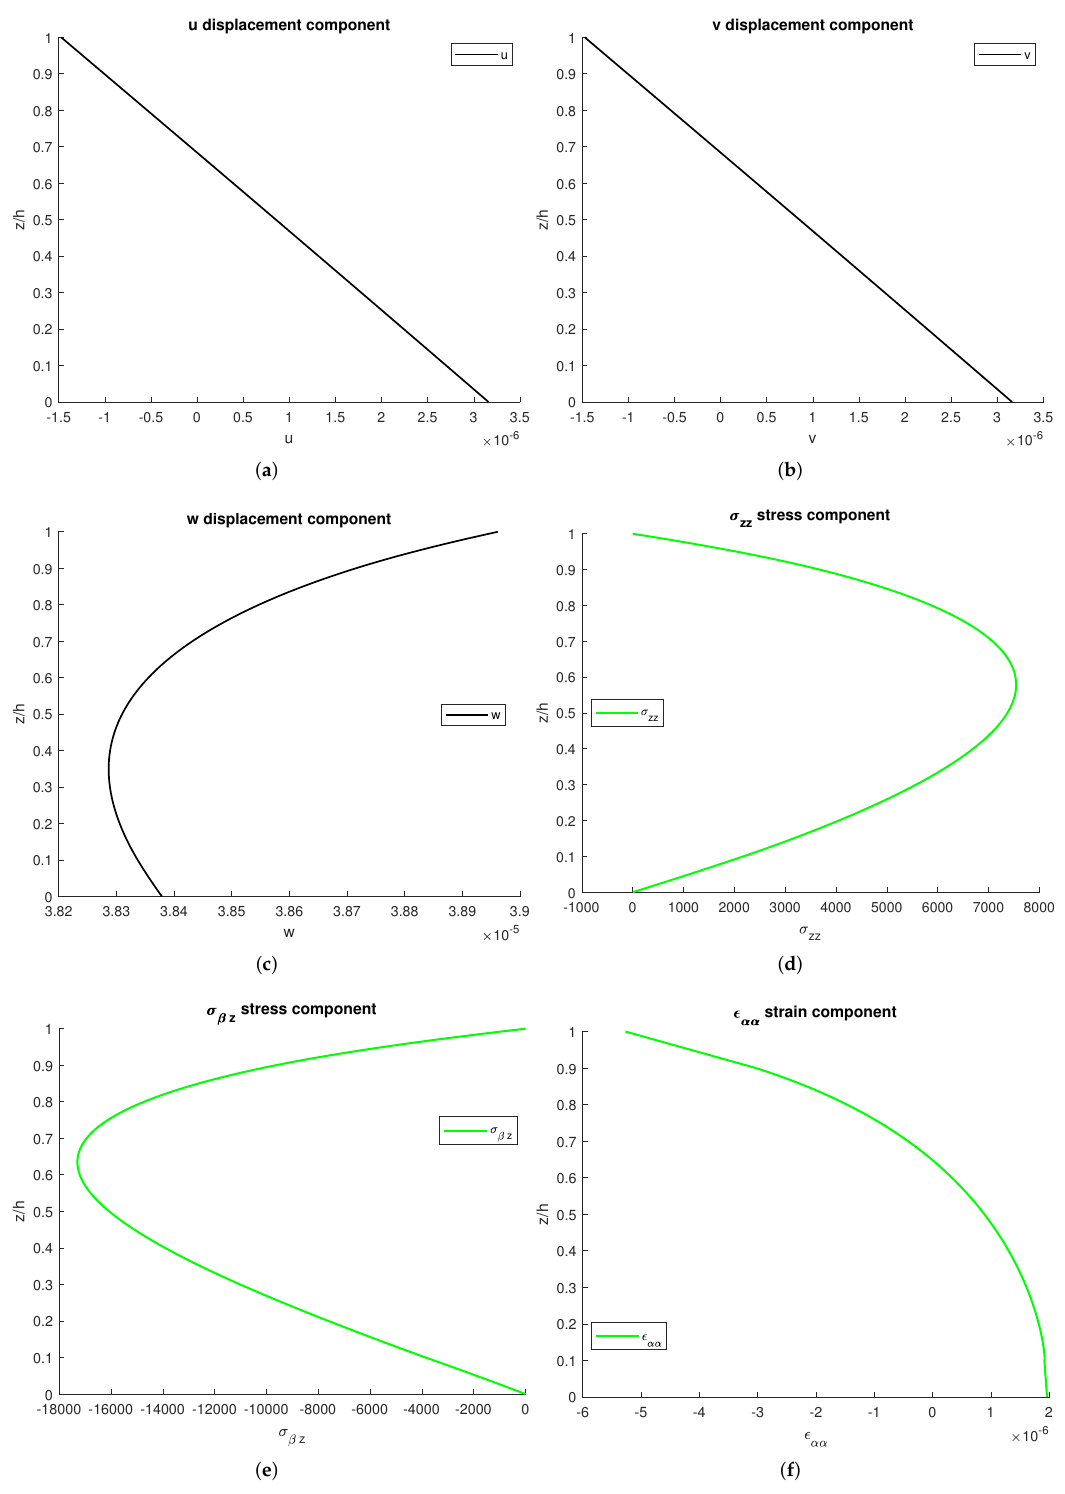
Figure 10. Fourth benchmark: spherical sandwich shell panel featuring a FGM ( p = 0.5) core with an imposed moisture content on the top and bottom surfaces. The results are calculated for a thin ( R α / h = 50) structure via the 3D( M c ,3 D ) model. ( a ) Amplitude of u displacement component. ( b ) Amplitude of v displacement component. ( c ) Amplitude of w displacement component. ( d ) Am- plitude of σ zz stress component. ( e ) Amplitude of σ β z stress component. ( f ) Amplitude of (cid:101) αα strain